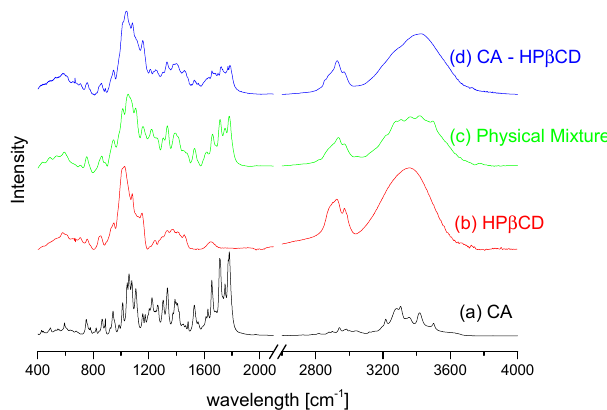
Figure 6. The FT-IR spectra of CA ( a ), HP β CD ( b ), their physical mixture ( c ), and prepared system ( d ).